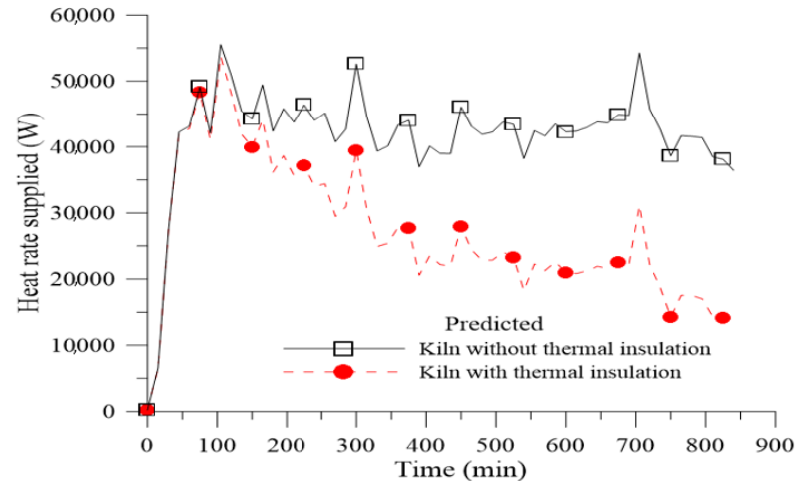
Figure 26. Heat rates supplied for the kiln with and without thermal insulation as a function of time. Figure 26